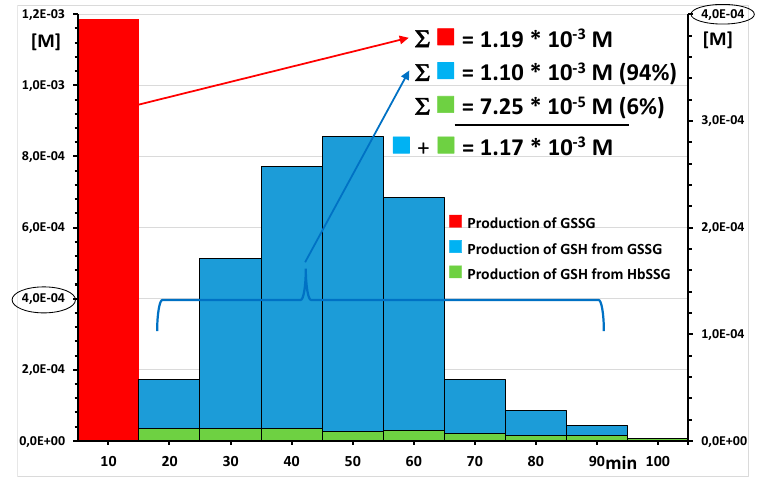
Figure A5. Histogram plot of the matter balance of RBC glutathione oxidized as its disulfides (red bar) and of its recovery over the experiment time by reduction of glutathione disulfide (blue bars) and of glutathionyl-hemoglobin (green bars). Concentrations (M, vertical axes) of each thiol are expressed as GSH equivalents. Therefore, GSSH concentrations are multiplied by two. The right vertical axis has been expanded to one-third of the scale of the left one for clarity at the different times, each bar represents the GSH formed, calculated as the concentration difference from the previous time point. Calculations in the insert show the mass balance, where the concentration of recovered GSH matches that of glutathione oxidized to the disulfides in the oxidative